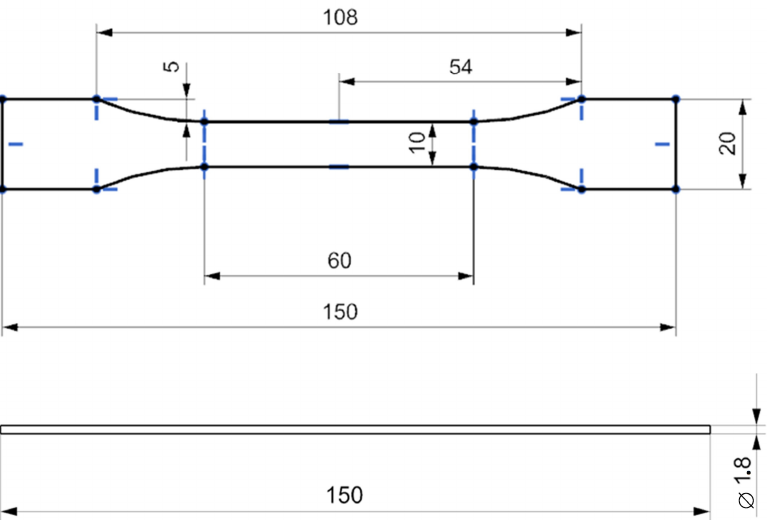
Figure 1. 3D printed specimens ( top ) and filaments ( bottom ) for tensile